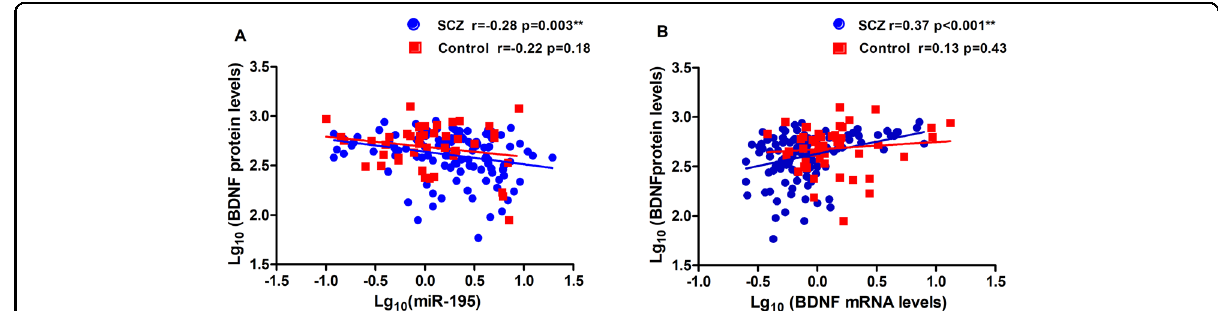
Fig. 1 The relationship between miR-195, BDNF mRNA, and protein levels. A miR-195 levels were negatively associated with BDNF protein levels in patients with schizophrenia ( p = 0.003, signi fi cant after Bonferroni correction) but not in healthy controls although they were in the same trend. B BDNF mRNA levels were signi fi cantly and positively associated with BDNF protein levels in patients with schizophrenia ( p < 0.001) but not in healthy controls. **Statistically signi fi